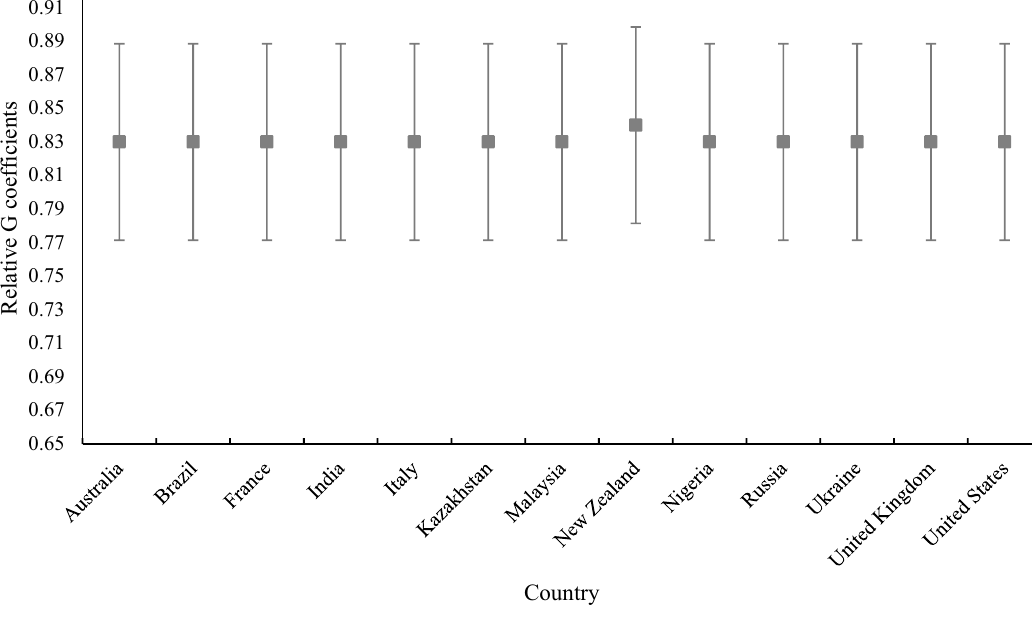
Figure 2. Graphical representation of reliability by relative G coefficient for each country including 95% confidence intervals.